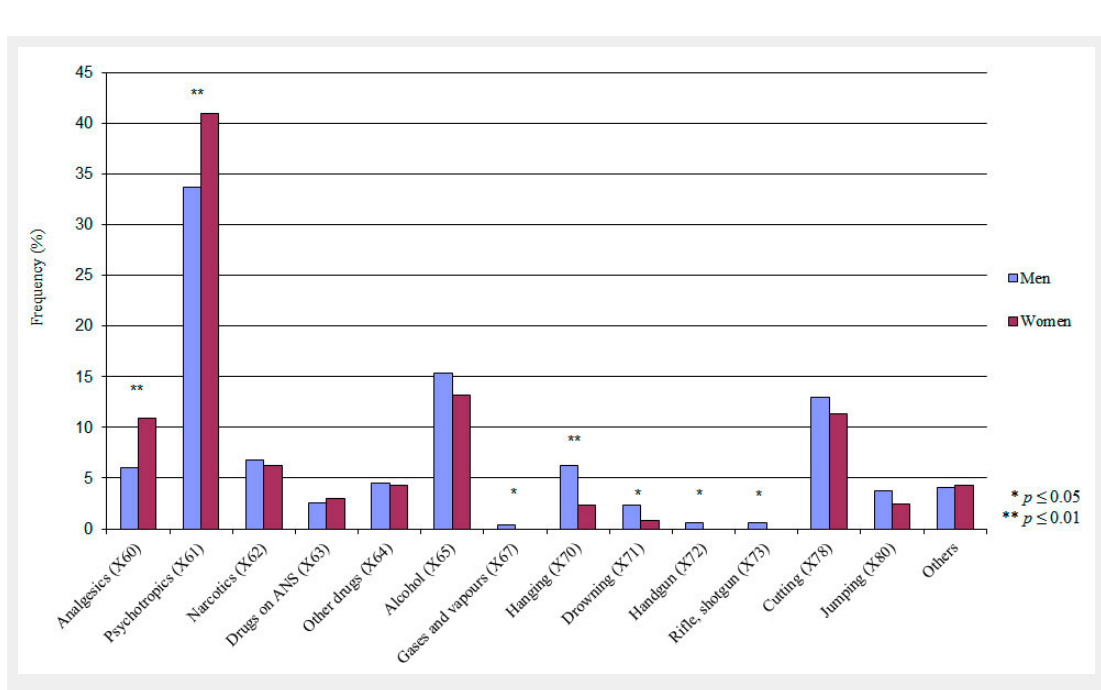
Distribution of the suicide attempt methods according to ICD-10 (multiple nominations). ANS = autonomous nervous system (X63).